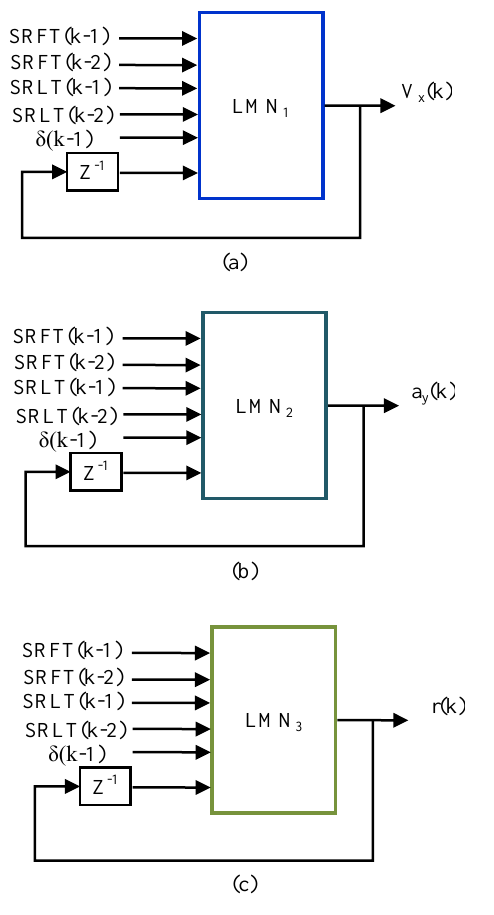
Figure 4. Structure of LMN for estimation of (a) longitudinal velocity, (b) lateral acceleration, and (c) yaw rate.